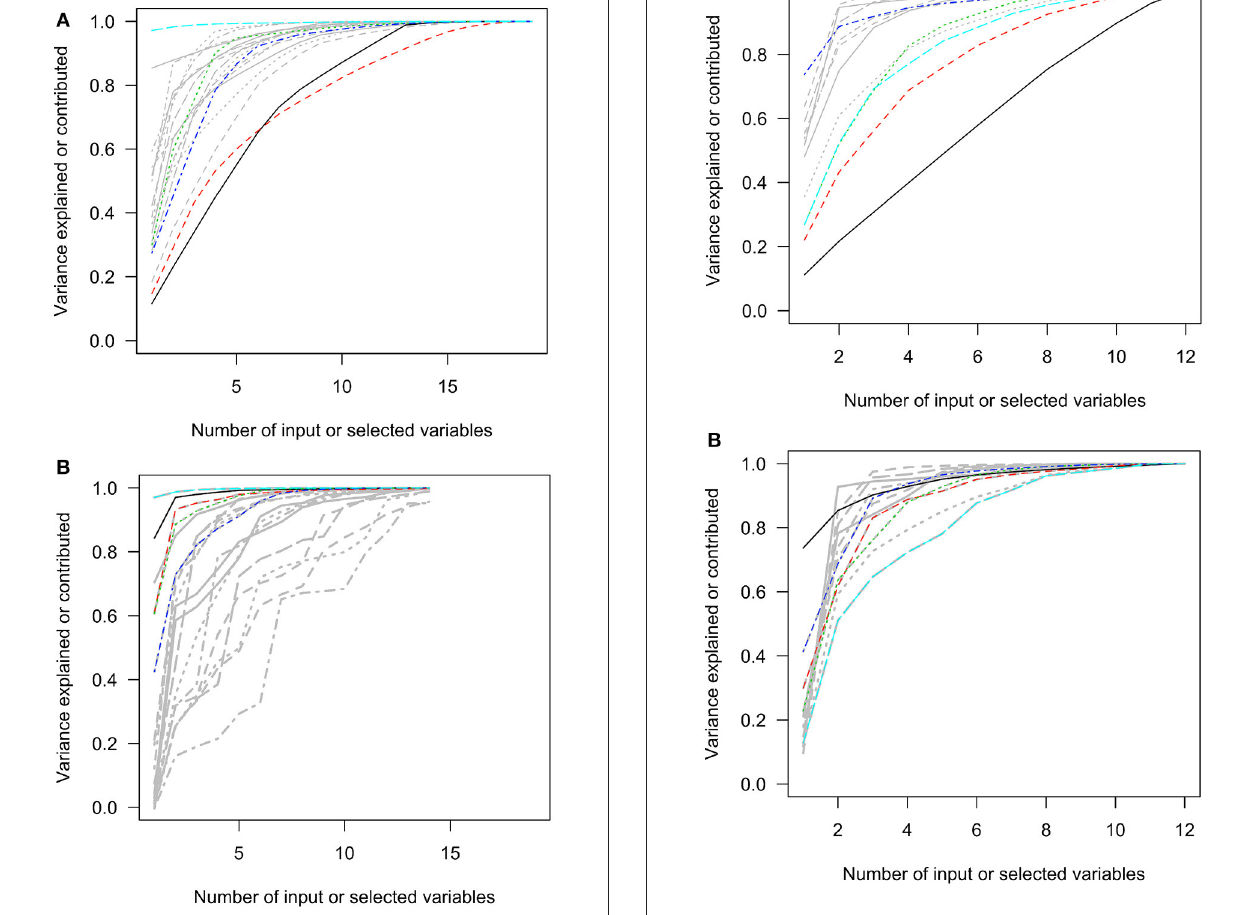
FIGURE 3 | The squared loadings in each PC and the R squared of PC approximation in the MEPS SF-12v2 subset data. (A) The squared loadings of all variables in PCs. (B) The adjusted R squared of the variables that were used to approximate PCs. MEPS, Medical Expenditure Panel Survey; PC, principal component; SF-12v2, the Short-Form 12 Version 2. Black, first PC; red, second PC; green, third PC; blue, fourth PC; light blue, fifth